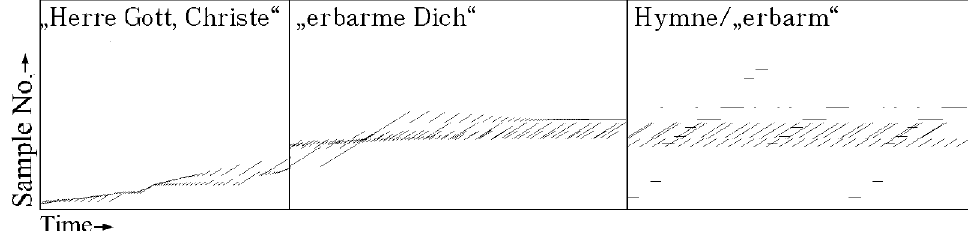
Figure 6: A surf chart for the input sound wave for Herre